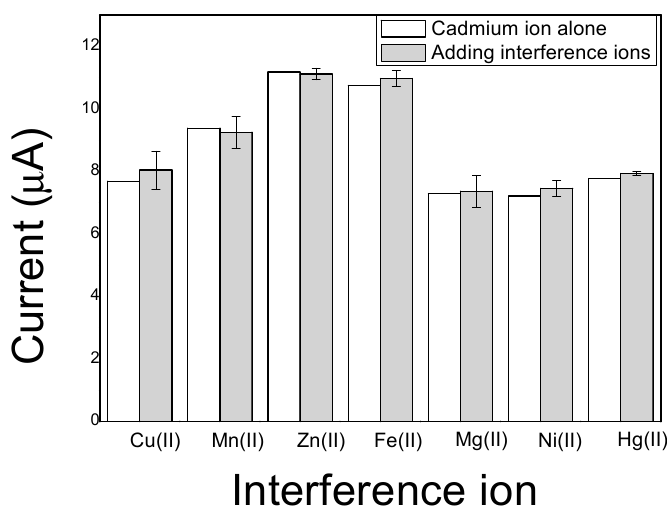
Figure 12. E ff ect of di ff erent interference ions on peak current detection of Cd(II). Figure 12. Effect of different interference ions on peak current detection of Cd(II).